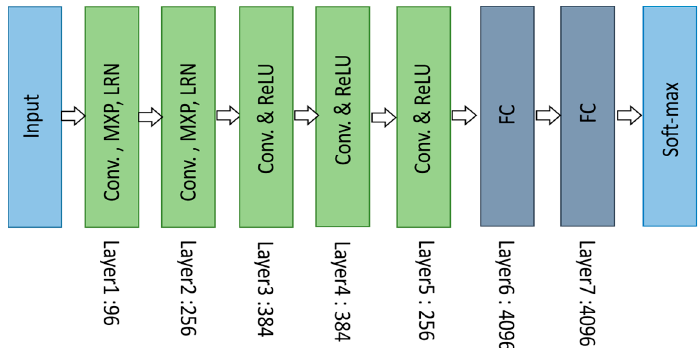
Figure 12. The architecture of AlexNet: Convolution, max-pooling, Local Response Normalization (LRN) and fully connected (FC) layer.